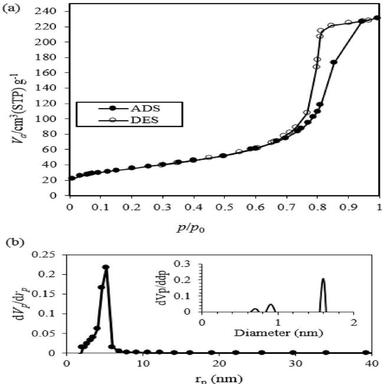
(a) Adsorption/desorption isotherms of N2 gas and (b) respective pore size distributions of the as-prepared alumina.